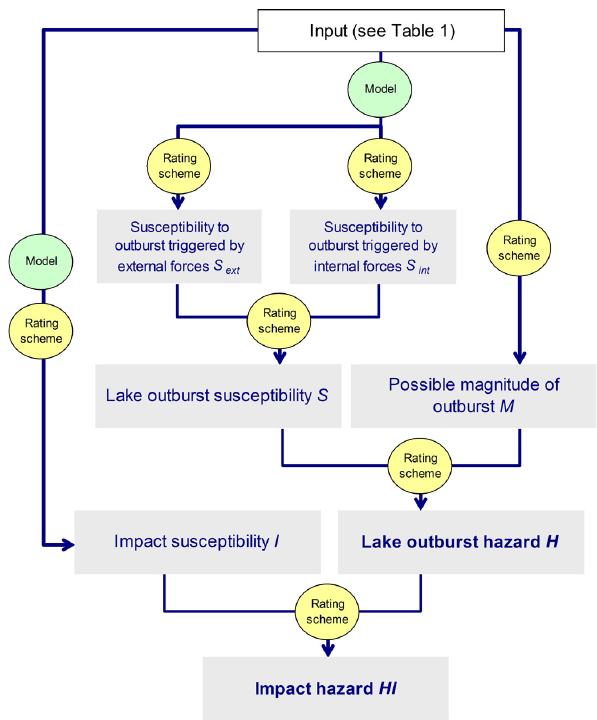
Table 1. Parameters used as input for the regional-scale lake outburst hazard analysis (see Fig. 2). Parameter Shortcut Unit Source Lake drainage boolean Qualitative interpretation of satellite imagery Dam type nominal (ASTER, WorldView, GoogleEarth) Possible calving into lake boolean Elevationa.s.l. z m Computed from lake centroid and DEM Freeboard F m Lake area A m 2 Derived from mapped lakes Average lake depth D m Empirical relationship with lake area (Eq. 1) Lake volume V m 3 Derived from lake area and average lake depth (Eq. 2) Lake area development r A 1 ratio Comparison of lake areas derived by multitemporal 1968–2007/2008 analysis of satellite imagery Lake area development Maximum Peak Ground PGA max ms − 2 Map of active faults and published relationships Acceleration